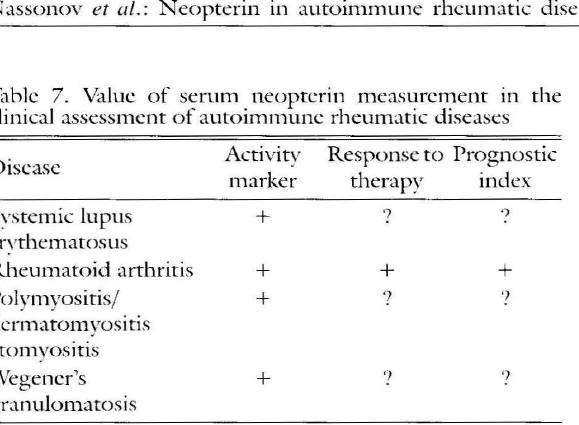
Table 7. Value of serum neopterin measurement in the clinical assessment of autoimmune rheumatic diseases Disease Svstemic